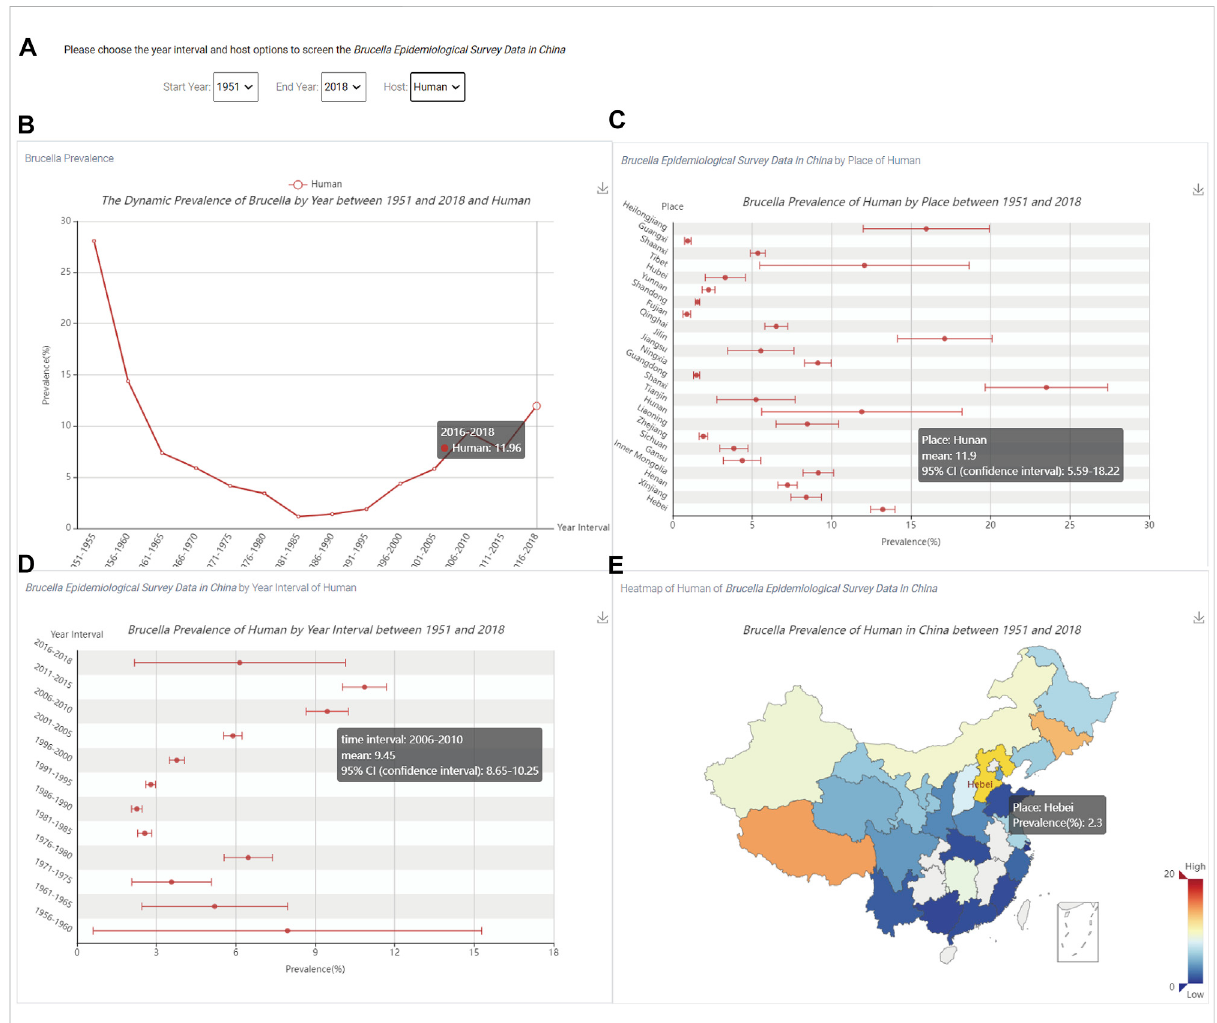
FIGURE 6 The visualization of the prevalence of Brucella in China. (A) The three option boxes; (B) The trend of human Brucella prevalence level; (C) The prevalence of Brucella by region; (D) The prevalence of Brucella for each time period; (E) The spatial distribution of the prevalence of Brucella